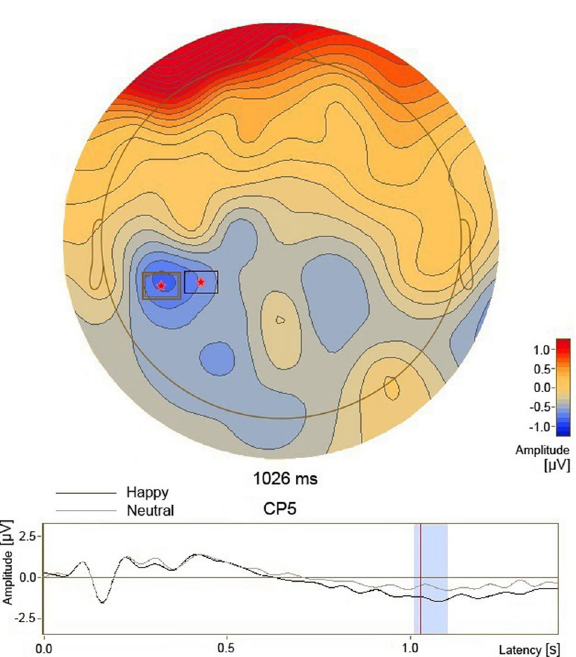
Figure 5. Significant clusters obtained from comparison between the sad condition and the neutral condition. The electrodes in the significant clusters were marked with asterisks and boxes and the differences in scalp voltages between the two conditions were shown in the upper panel. The low panel showed the ERP waveforms of typical electrodes PO8, P6 and AF4 in the significant clusters in the two conditions, and the time periods when the ERP amplitudes were significantly different between conditions.